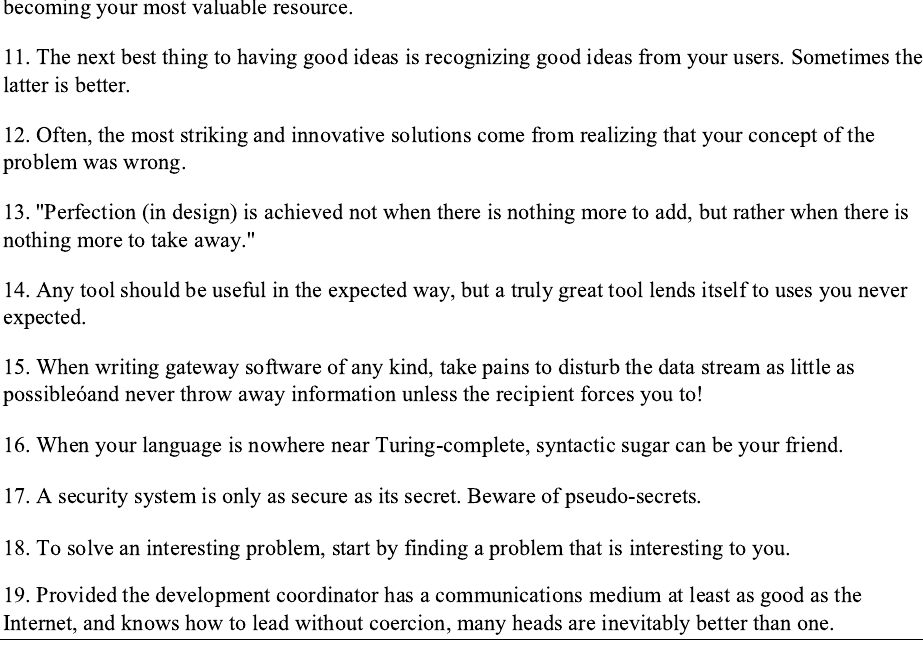
Figure 1. Eric Raymond’s lessons of the bazaar (summarized from Raymond